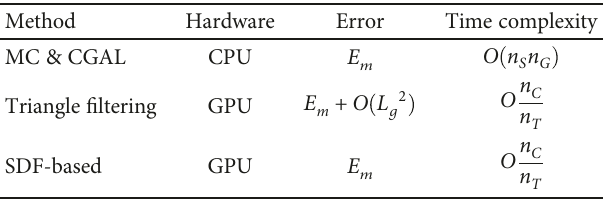
threads and n T C